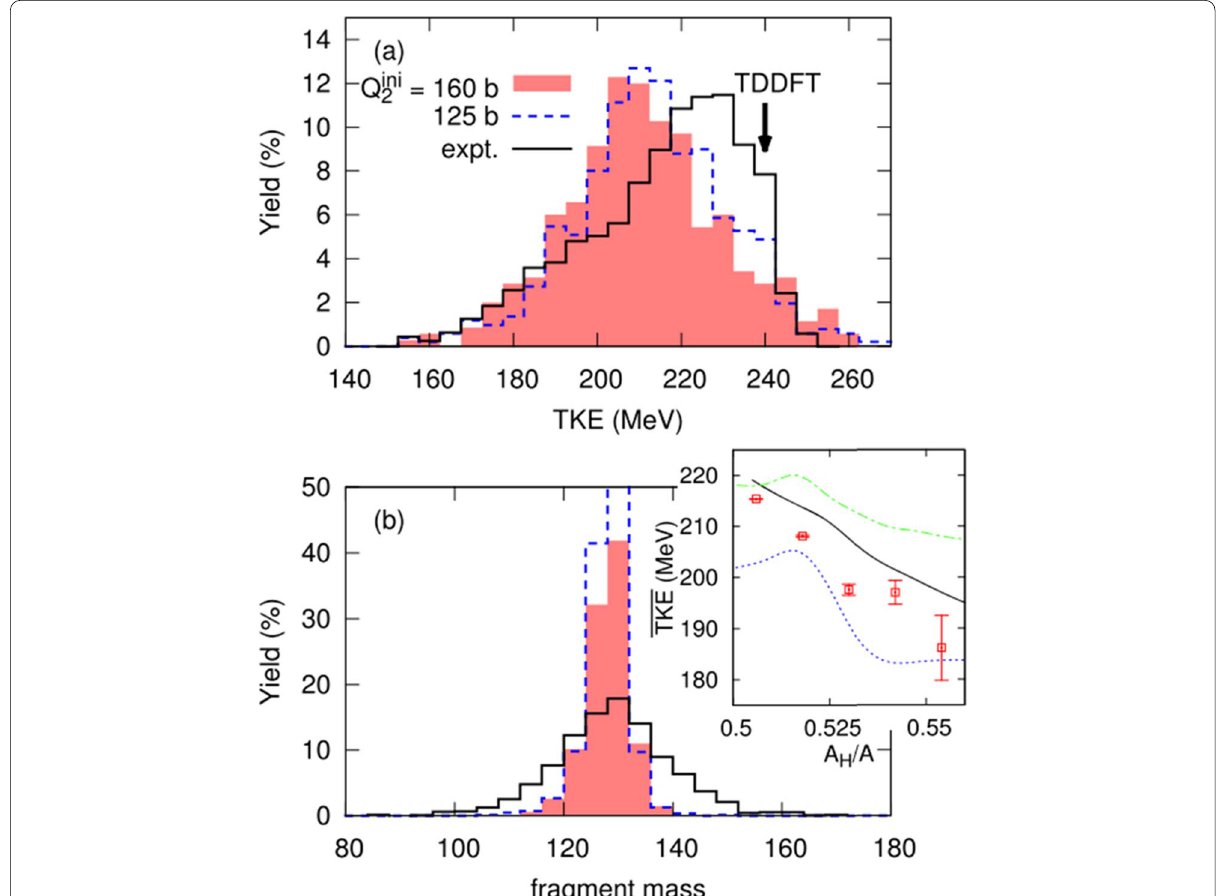
Fig. 15 The TKE ( a ) and fragment mass ( b ) distributions obtained when an elongated (shaded areas) and compact (dashed lines) initial post-saddle deformations are considered. The solid lines are the experimental data [116]. In a , the arrow indicates the mean experimental TKE. In the inset of b , the correlation between the average TKE and heaviest fragment mass (red squares) is compared with results from the scission point model [117] (dotted and dot-dashed lines). 257 Fm data [118] is shown by the solid line. The figure is adapted from